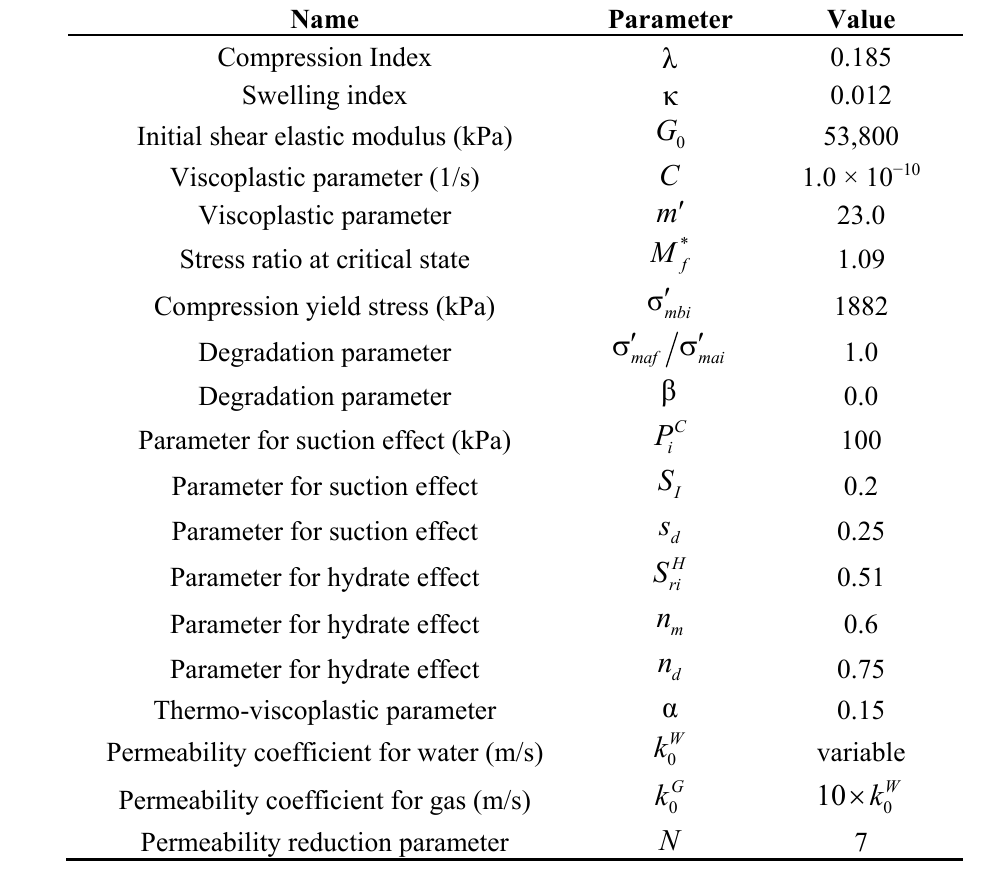
Table 2. Material parameters for the constitutive equation